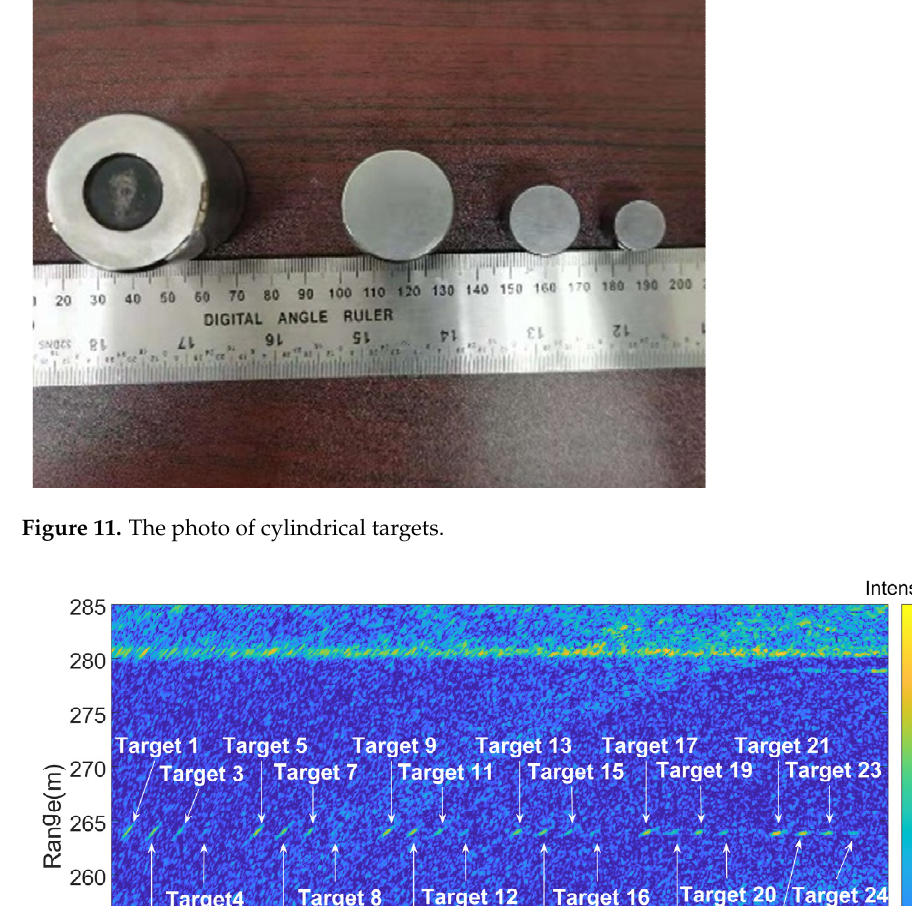
Figure 10. The phase change history of SPCPs: ( a ) with the same range and different azimuths; ( b ) with different ranges and the same azimuth.